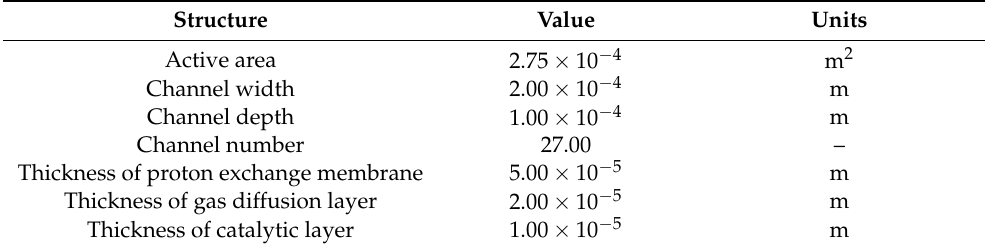
Table 1. The detailed parameters of fuel cell.